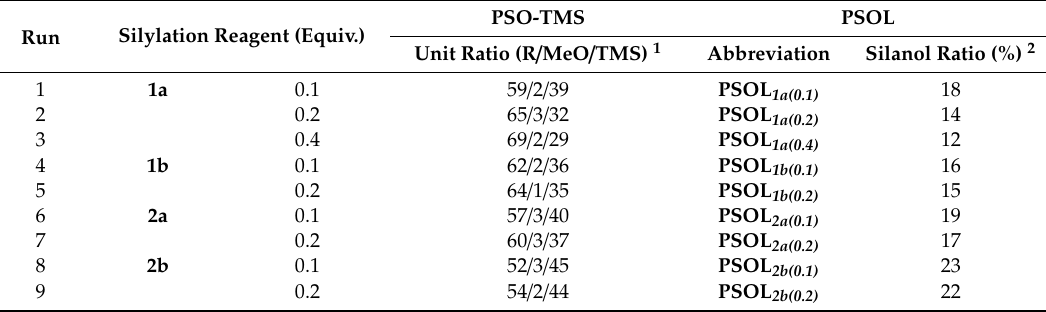
Table 1. Preparation of PSOL 1 and PSOL 2